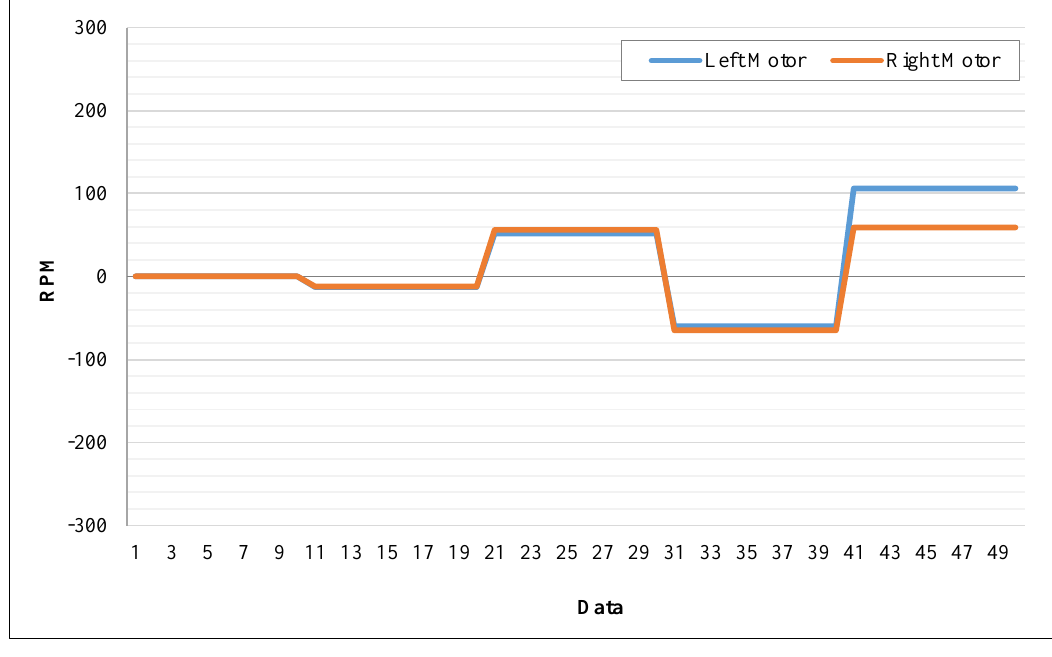
Figure 16. System's motor speed response without PID